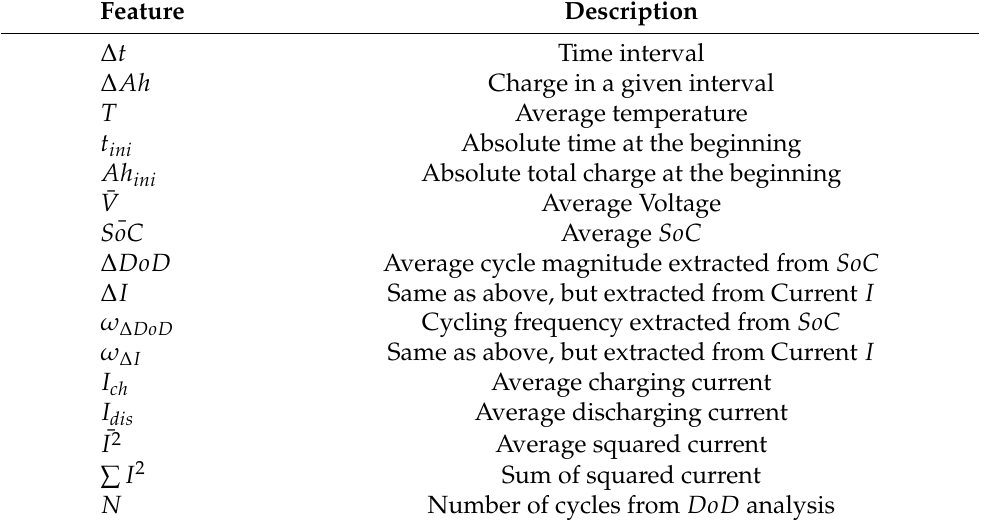
Table 4. Extracted